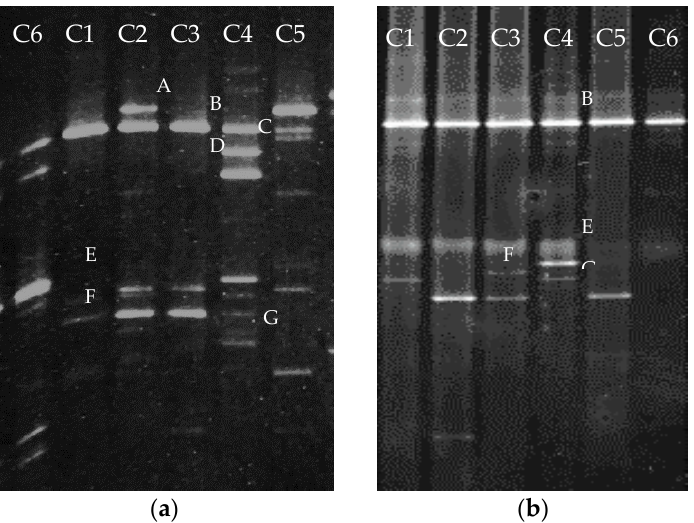
Figure 1. Comparison of PCR-DGGE profile of six different bacterial consortia in ( a ) initial generation and ( b ) after 10th generation.